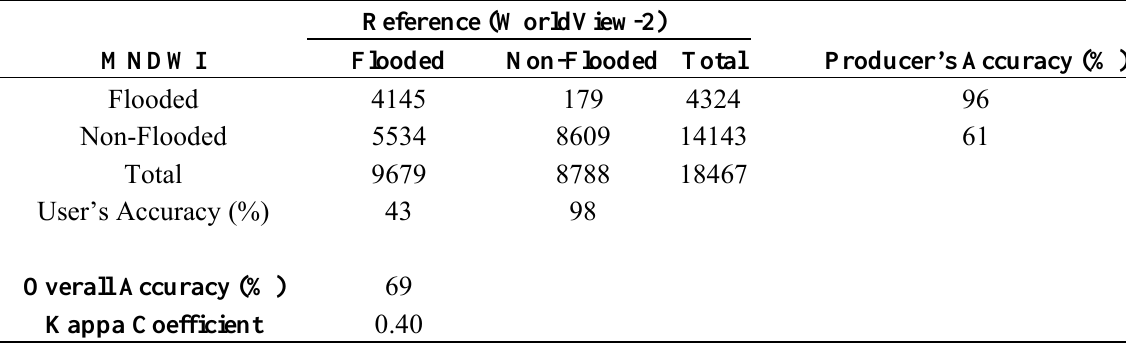
Table 2. Error matrix of the pixel-to-pixel validation between the post-flood Modified Normalized Difference Water Index (MNDWI) and the WV-2 reference